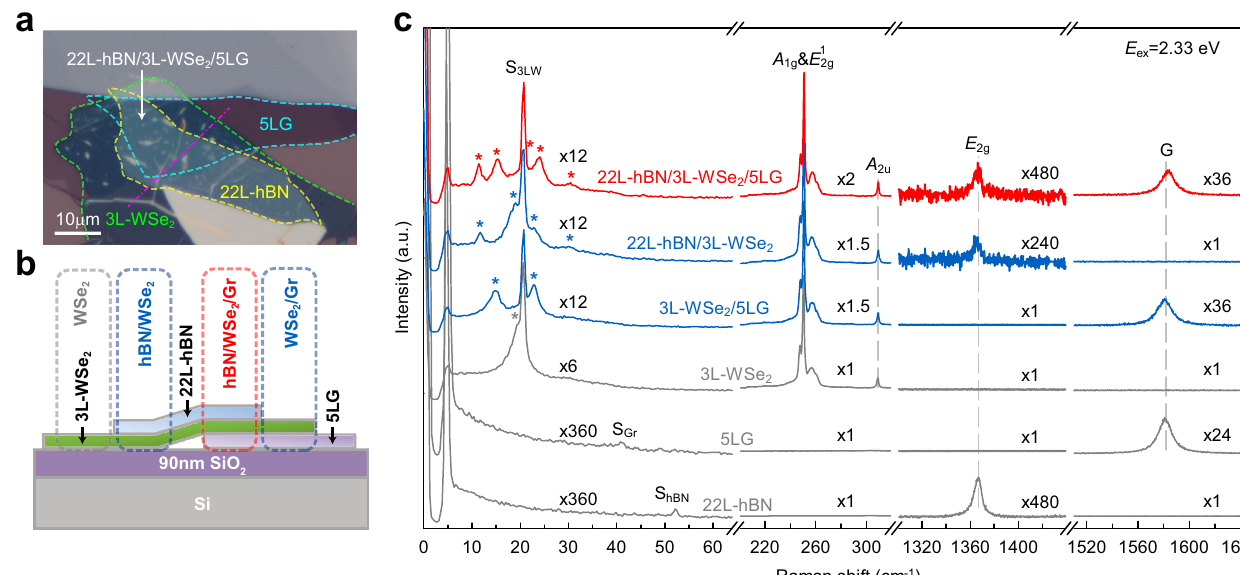
Fig. 1 Raman signatures of hBN/WSe 2 /Gr vdWH and its constituents. a Optical image of the sample containing 22L-hBN/3L-WSe 2 /5LG, 22L- hBN/3L-WSe 2 , 3L-WSe 2 /5LG, and 3L-WSe 2 . b Schematic diagram of cross-section of the sample along the dash-dotted line in a . The regions of ternary vdWH, binary vdWHs, and pristine WSe 2 fl akes are indicated. c Raman spectra of 22L-hBN, 5LG, 3L-WSe 2 , 3L-WSe 2 /5LG, 22L-hBN/3L- WSe 2 , and 22L-hBN/3L-WSe 2 /5LG. Stars indicate the LB modes. S 3LW , S Gr and S hBN denote the S modes of 3L-WSe 2 , multilayer graphene and hBN fl akes,